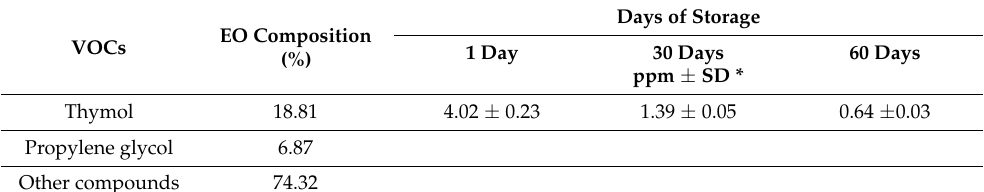
Table 3. Composition of thymol formulation and characterization of the atmosphere of cabinet during the storage trial on apples ‘Opal’ obtained by GC-MS and SPME-GC-MS analysis, respectively. Air in the cabinet was sampled at 1, 30, and 60 days of storage.